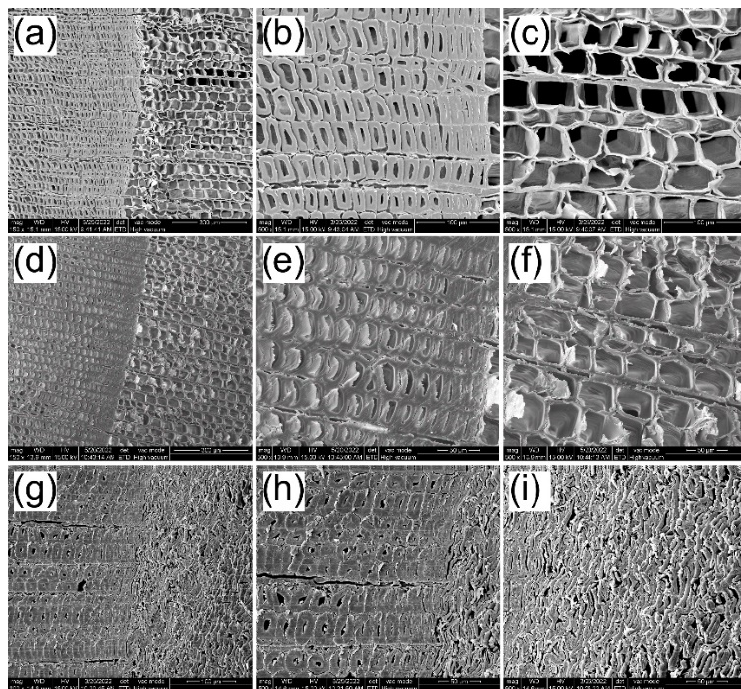
Figure 4. SEM images of wood samples: ( a ) control sample, ( b , c ) enlarged images of earlywood and latewood in ( a ), respectively; ( d ) acetylated sample, ( e , f ) enlarged images of earlywood and latewood in ( g ), respectively; ( g ) AD-60 sample, ( h , i ) enlarged images of earlywood and latewood in ( g ),